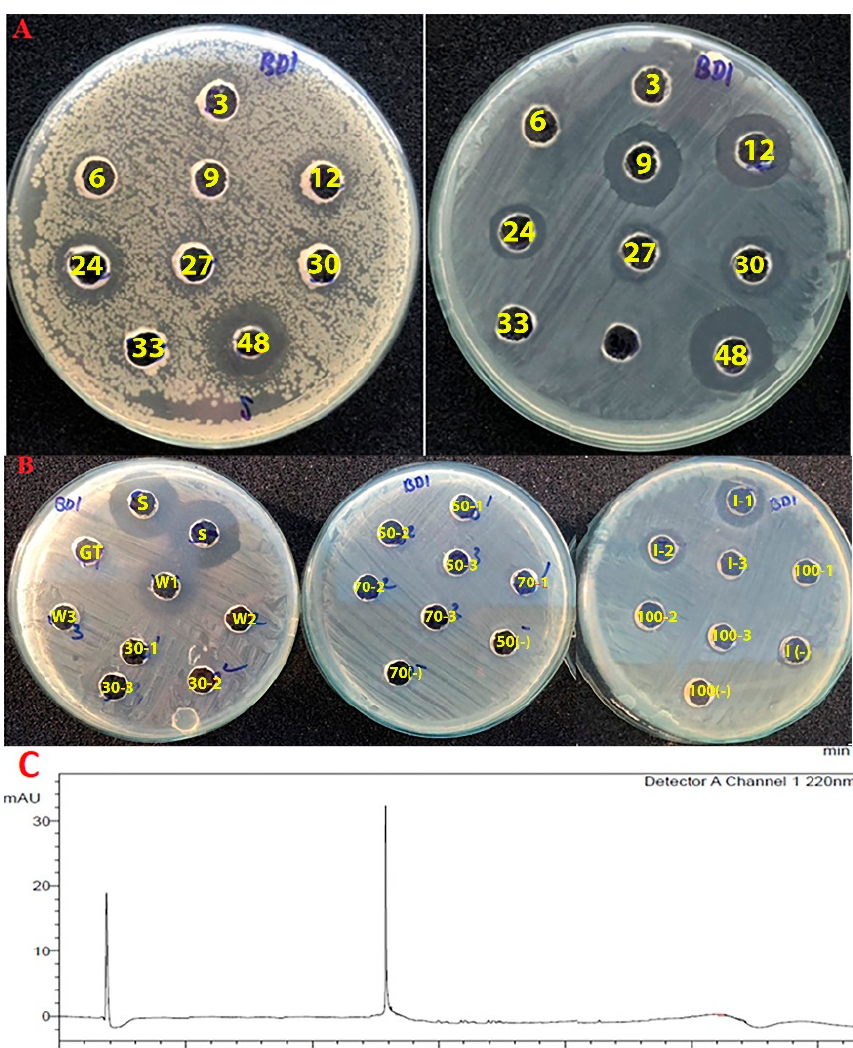
Figure 3. Purification of the anti- Vibrio bacteriocin produced by B. methylotrophicus NTBD1. ( A ) Anti- Vibrio activity (left) and anti- Listeria activity (right) of the bacterial cultures obtained by different cultivation times. Wells (3)–(48) reflect cultures collected after 3–48 h, respectively. ( B ) Purification of bacteriocin crude extract by hydrophobic-interaction chromatography. Anti- Vibrio activity of crude extract (S), crude extract after loading through column (GT), the column-wash with 2% methanol (0.1% TFA) (W), column-elutes with 30% (30), 50% (50), 70% (70), 70% isopropanol (0.1% TFA) (I), and 100% of methanol (0.1% TFA) (100), respectively. Each step was conducted with three column volumes (code (1–3) follows each solvent concentration), with each solvent used as a negative control (–). The results indicated that the column eluted with 70% isopropanol (I) showed anti- Vibrio activity. ( C ) Purification of this active fraction (I) by reverse-phase HPLC resulted in a bacteriocin peak at a retention time of 25.6 min, monitored only with a UV wavelength of 220 nm.